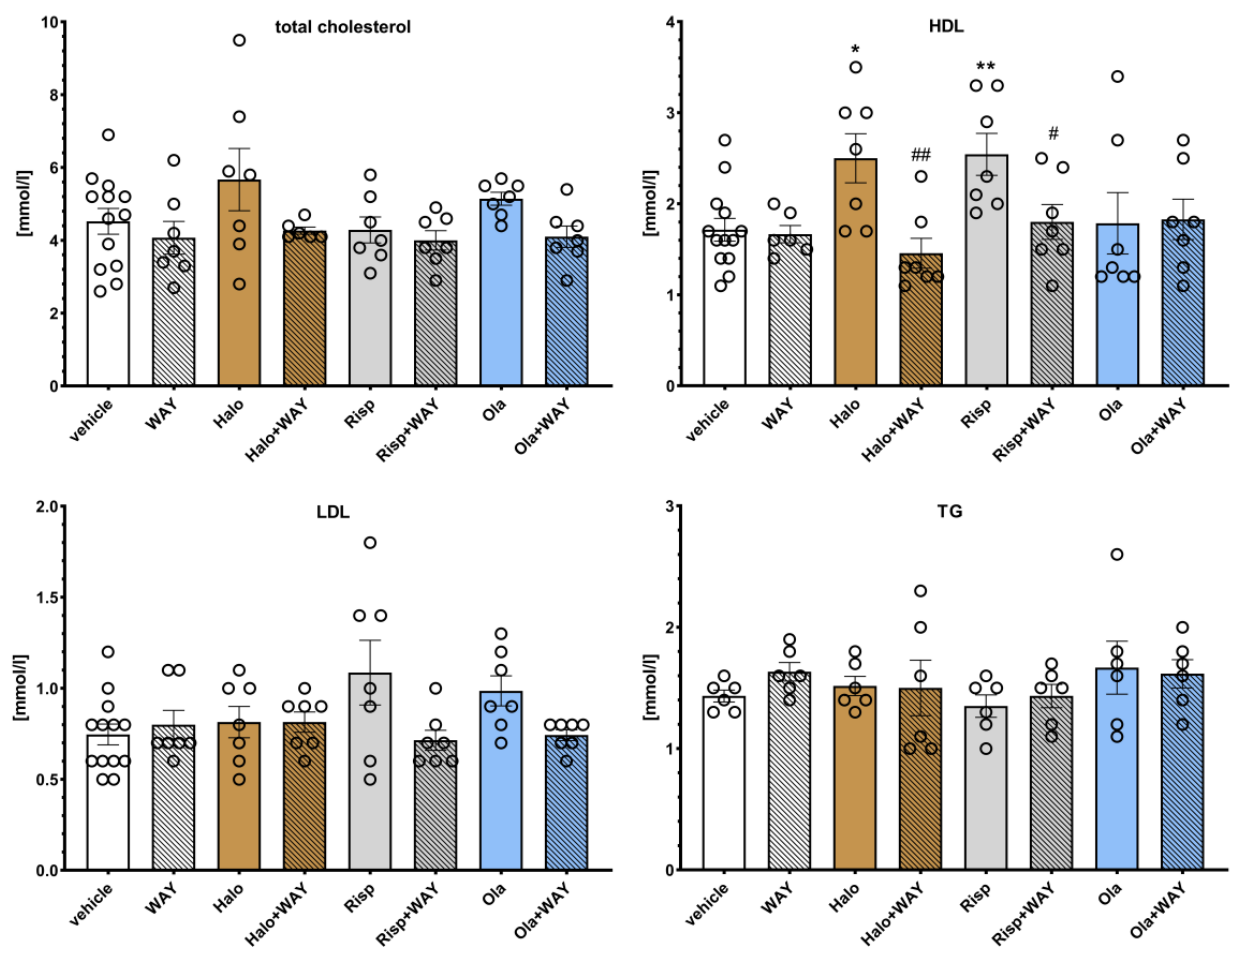
Figure 4. Effects of haloperidol, risperidone, olanzapine, and WAY-181187, administered alone and in combinations, on serum levels of total cholesterol, LDL, HDL, and TG in rats. The results are presented as mean ± SEM; n = 6–12. * p < 0.05, ** p < 0.01 versus the respective vehicle-treated group; # p < 0.05, ## p < 0.01 versus the respective APD-treated group (two-way ANOVA followed by Bonferroni’s post hoc test). Halo, haloperidol 0.5 mg/kg; Risp, risperidone 0.5 mg/kg; Ola, olanzapine 5 mg/kg; WAY, WAY-181187 3 mg/kg; LDL, low density lipoproteins; HDL, high density lipoproteins; TG, triglycerides.